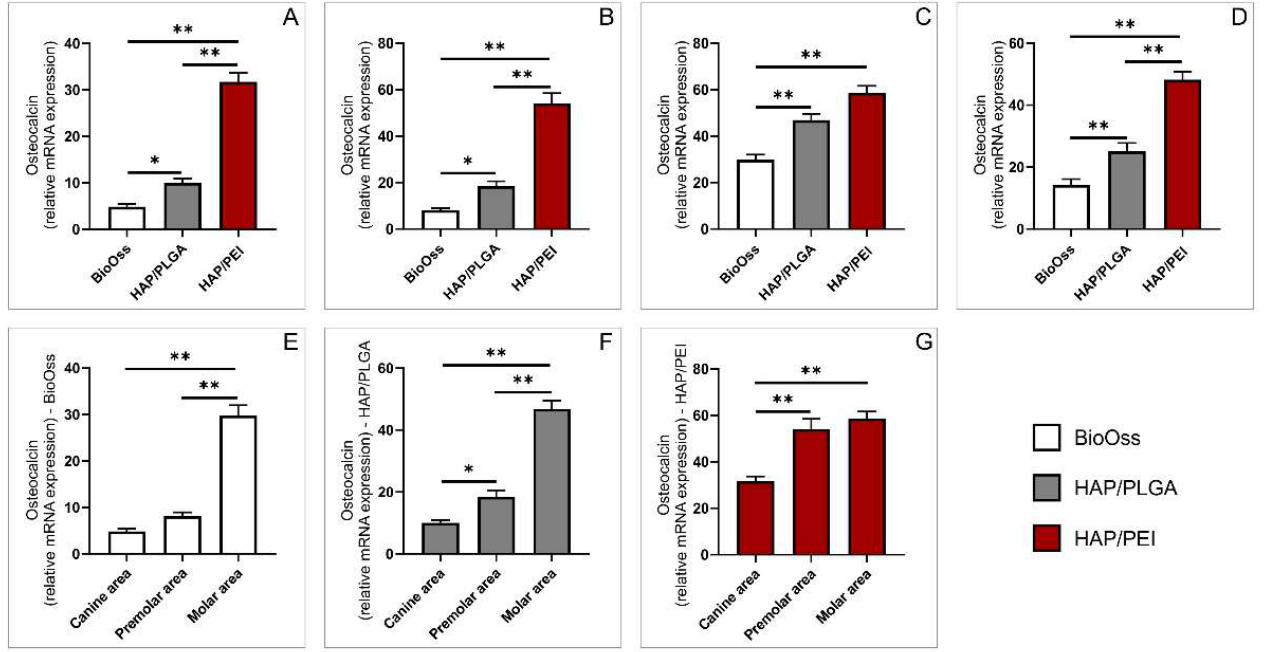
Figure 5. Relative expression of osteocalcin gene: ( A ) canine area, ( B ) premolar area, ( C ) molar area, ( D ) whole mandibula, ( E ) BioOss graft, ( F ) HAP/PLGA graft, ( G ) HAP/PEI graft. The values are mean ± standard error of the mean (SEM), * denotes a significant difference p < 0.05, ** denotes a significant difference p < 0.01.